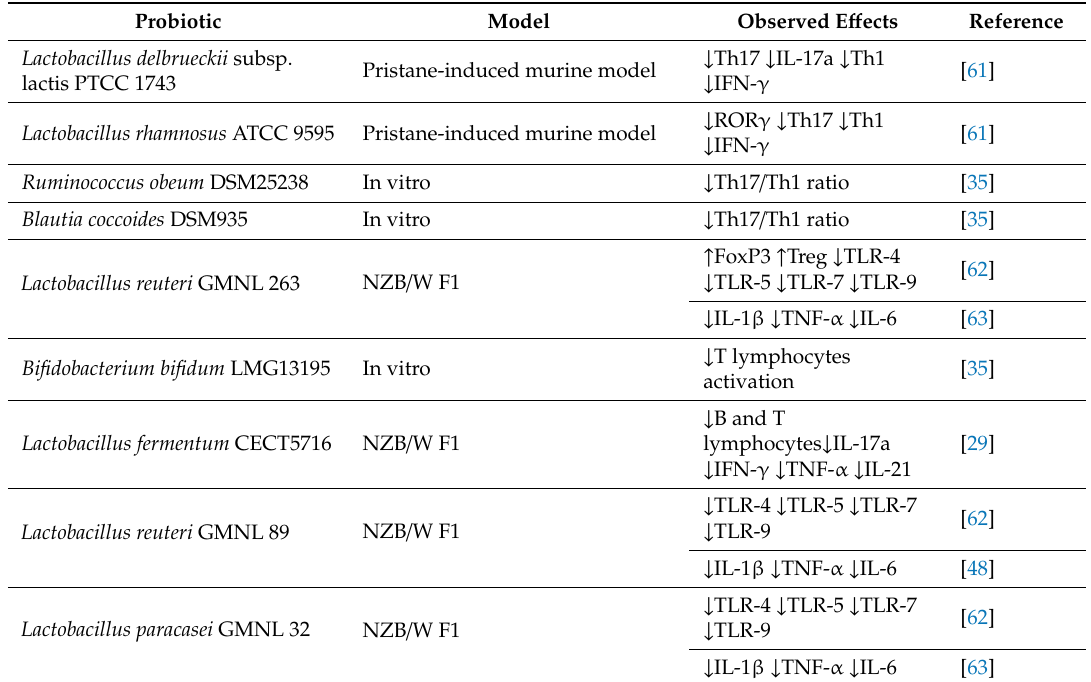
Table 3. Probiotic e ff ects in di ff erent lupus animal